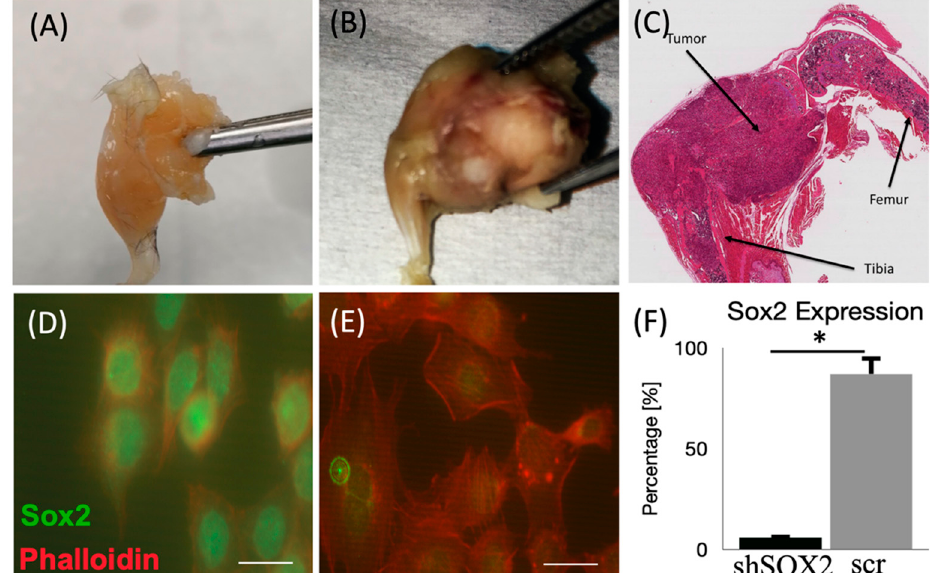
Figure 1. Spontaneous primary murine osteosarcoma and verification of Sox2 knockdown. Gross dissection of knee joint from ( A ) control mouse hindlimb and ( B ) Rb1 and p53 knockout mouse with significant OS tumor present. ( C ) Sagittal section through OS tumor hindlimb stained with standard H&E. ( D ) Immunofluorescence image of Sox2 (green) and actin (red) in ( D ) scr and ( E ) shSox2 treated cells; scale bar = 20 μ m. ( F ) Quantification of Sox2 positive cells in scr Vs shSox2; mean + SD; * p < 0.001; p value from Student’s t -test for statistical significance.